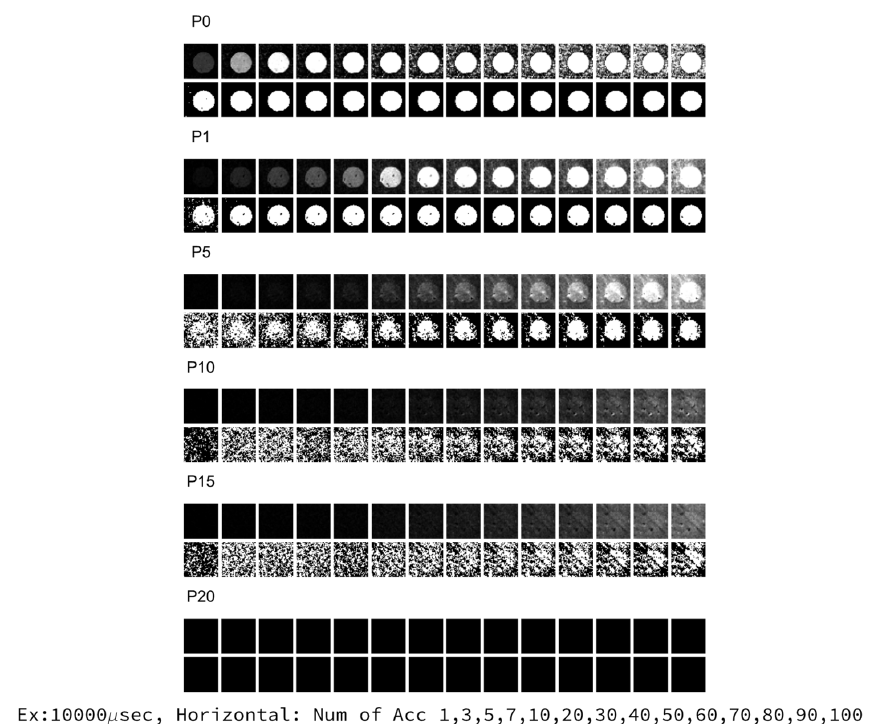
Figure A7. Si image of 48 × 49 px, Exp 10,000 μsec.